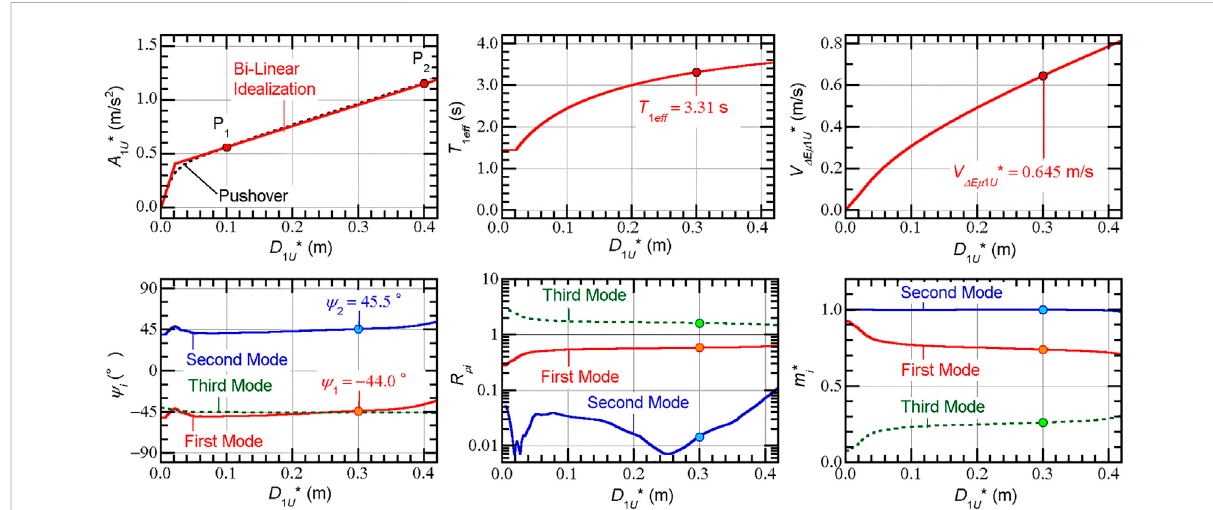
FIGURE 5 Modal parameters of the base-isolated model calculated from the pushover analysis results.